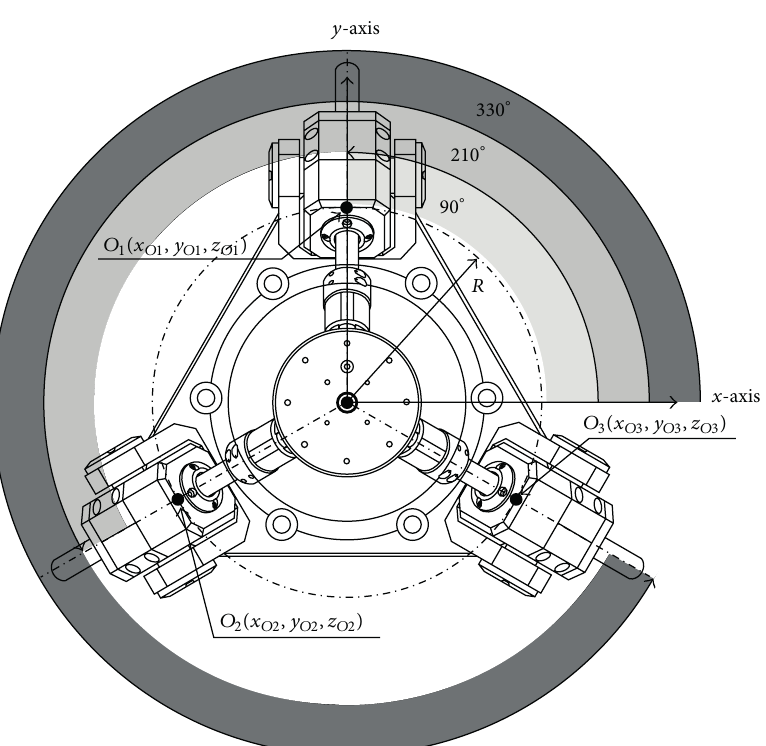
Figure 4: Geometry characteristic of the microrobot’s base.